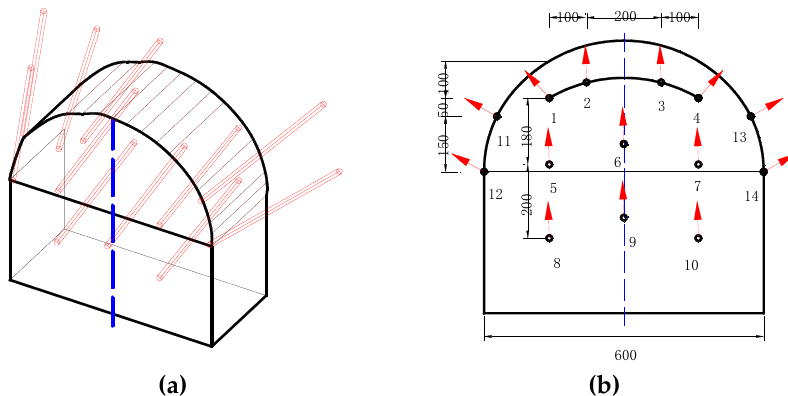
Figure 11. The change of maximum principal stress in surrounding rock before and after blasting: ( a ) Before blasting; ( b ) after blasting and ( c ) at the sidewall.